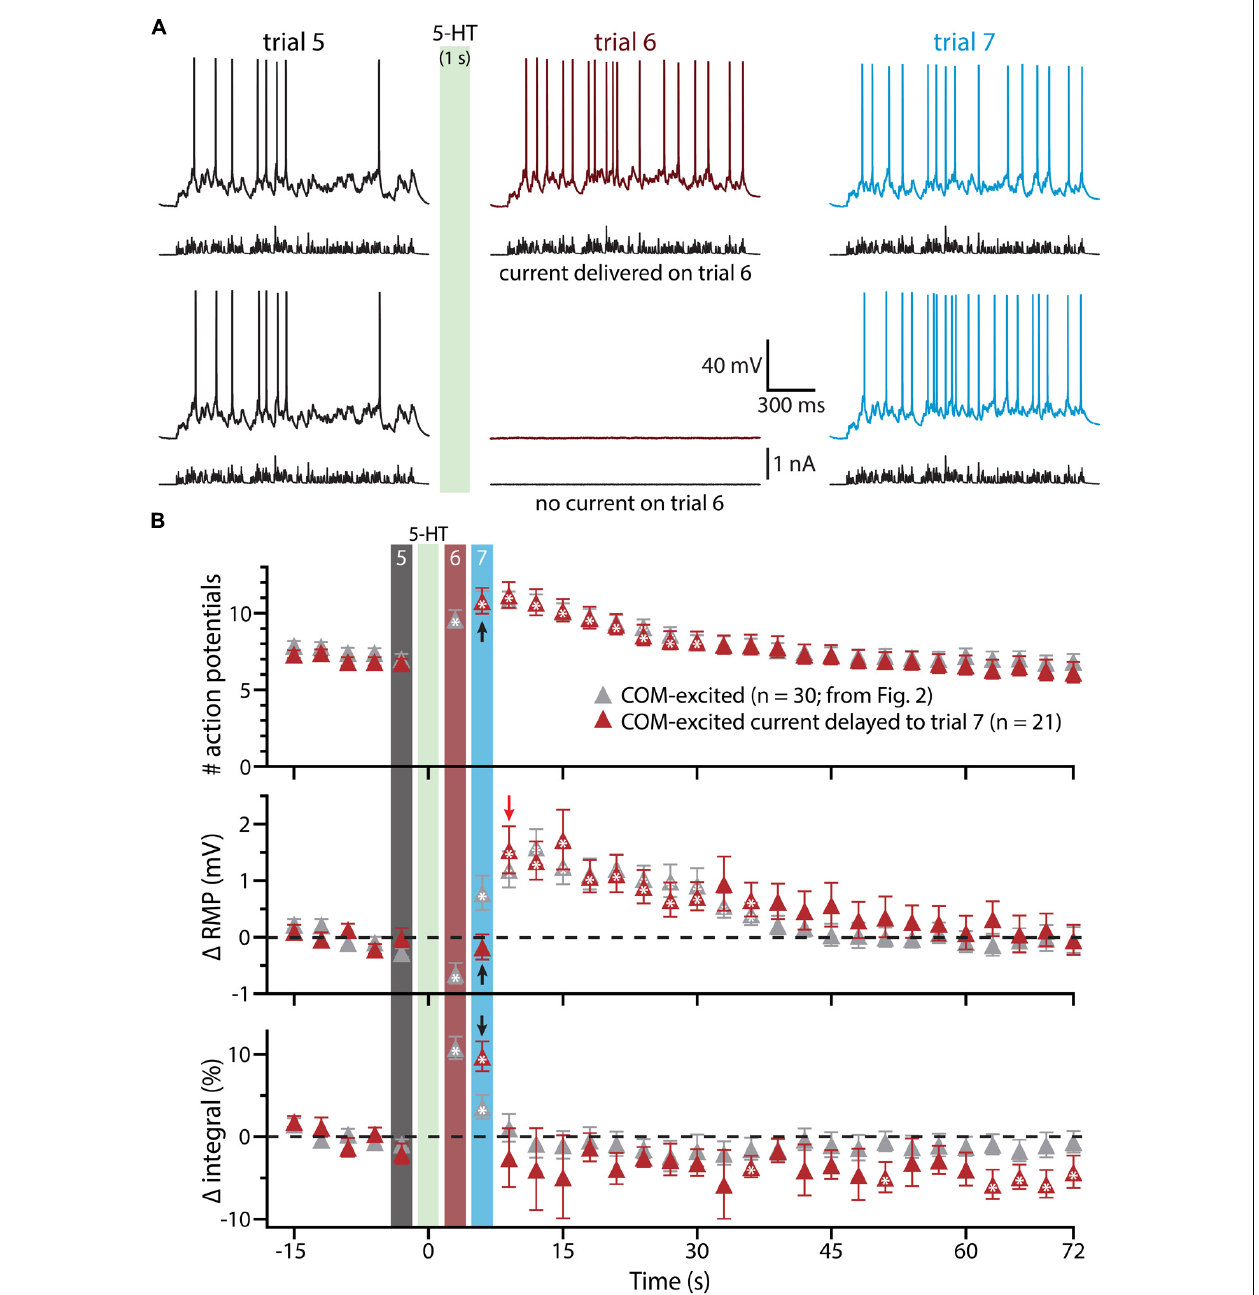
FIGURE 4 | Serotonergic depolarization of COM-excited neurons is facilitated by simulated synaptic drive. (A) Top traces: responses of a COM-excited L5PN to simulated synaptic currents delivered before (trial 5; left traces), immediately following (trial 6; middle traces), or 3 s after, 5-HT application (trial 7; right traces). Bottom traces: responses in a COM-excited L5PN in which no simulated synaptic current was delivered during trial 6 (middle trace; “blank” trial).The green bar indicates 5-HT application between trials 5 and 6 (see panel B ). (B) Plots of the number of action potentials (APs) generated by simulated synaptic current injection (top), changes in RMPs (middle), and percent changes in voltage response integrals (bottom) in